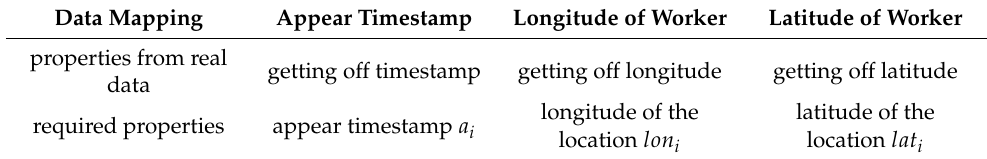
Table 2. Mapping table of partial attributes required by worker. Data